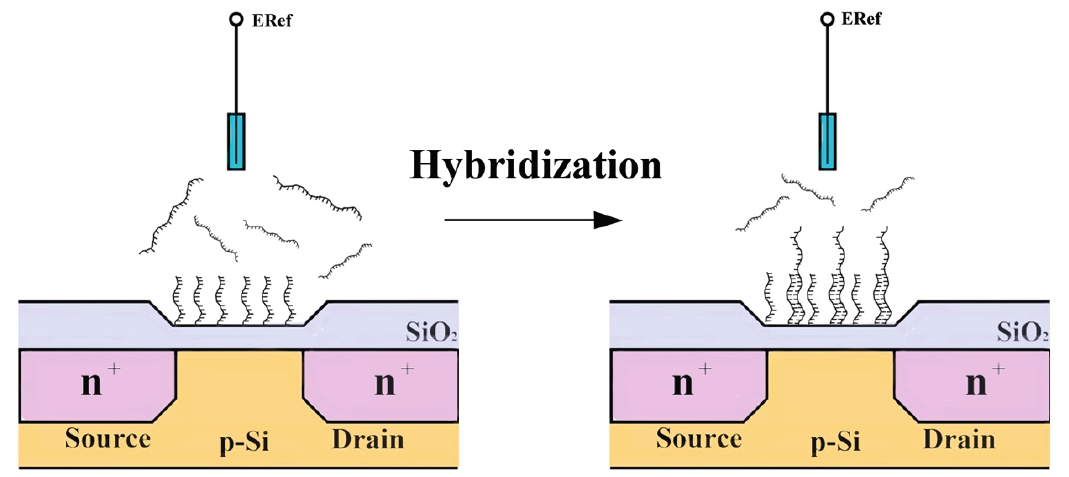
Figure 4. Schematic structure of a DNA modified thin film field effect device and the principle of DNA-hybridization detection. The change in DNA content, due to hybridization, yields a local charge variation and a rearrangement of ionic species near the sensor surface that modulate the sensor's